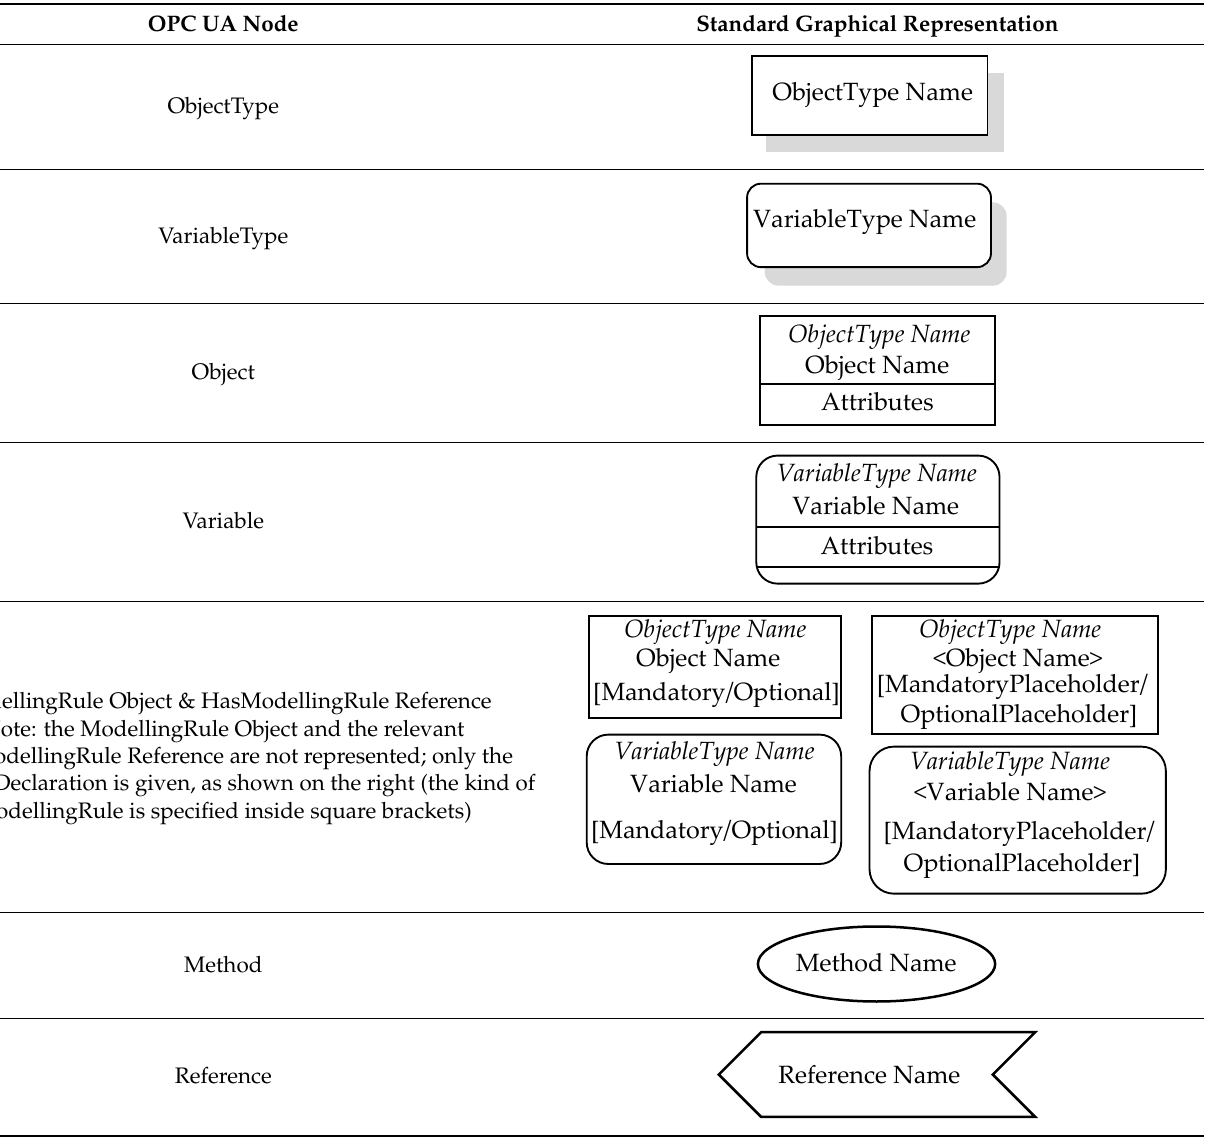
Table 2. Graphical representation of some OPC UA References.